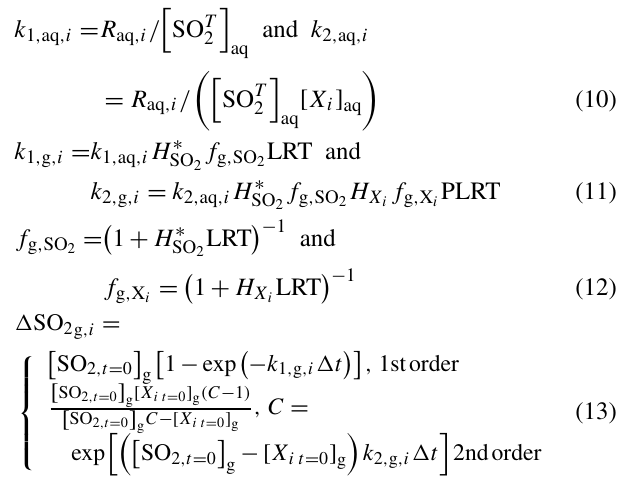
R aq ,i is the reaction rate (M s − 1 ). k 1 , aq ,i and k 2 , aq ,i are used to derive the first- and second-order rate constants for the heterogeneous reaction of SO 2 ( g ) and X i k 2 , g ,i (mol mol − 1 s − 1 ) (Eq. 11). H ∗ Henry’s law constants. f g , SO partitioning fractions of SO 2 and X i , respectively (Eq. 12).